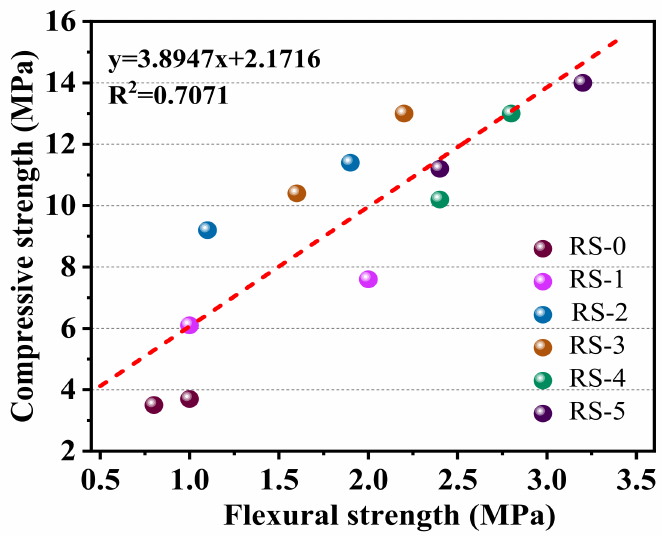
Figure 6. The relationship between compressive strength and flexural strength of composite cementi- tious materials with different slag